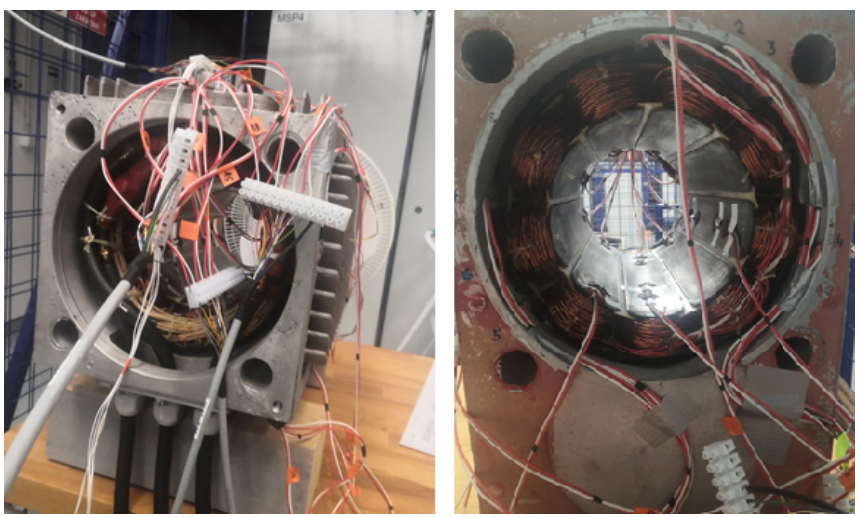
Figure 17. Thermo-couples in the